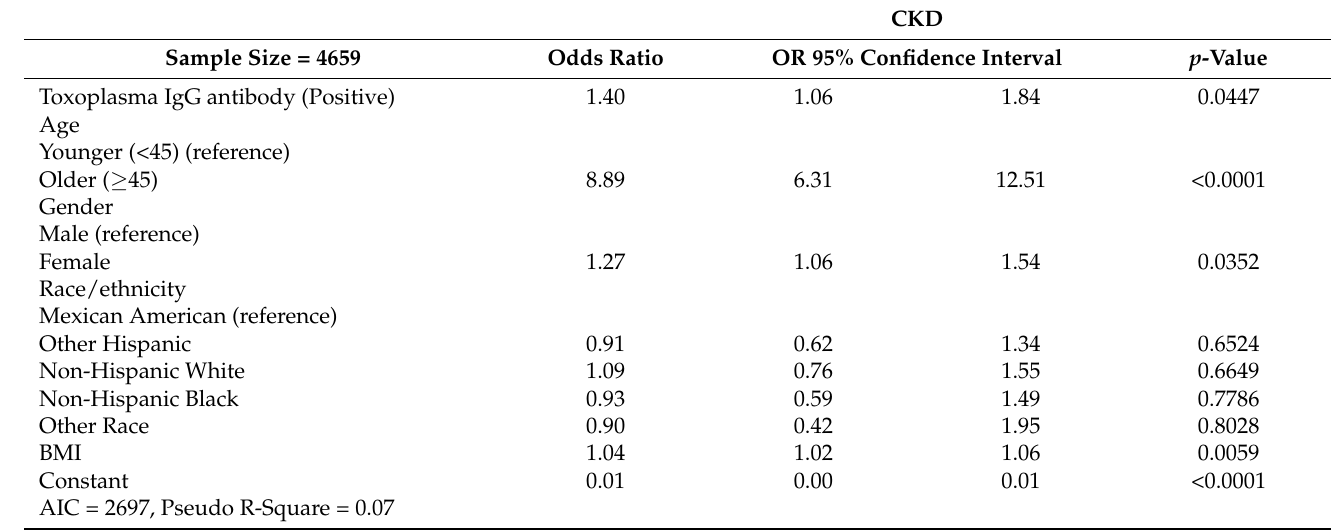
Table 4. Binomial Logistic regression model for CKD status on T. gondii IgG antibody (posi- tive/negative) adjusted for the demographic factors and BMI.